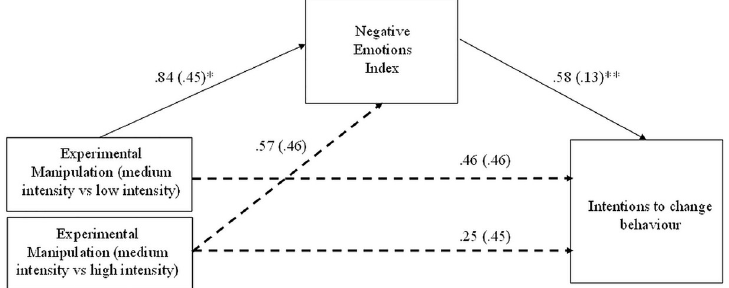
Fig 6. Indirect effect (IE) of experimental manipulation on the intention to change behavior via negative emotions evoked by the social campaign.